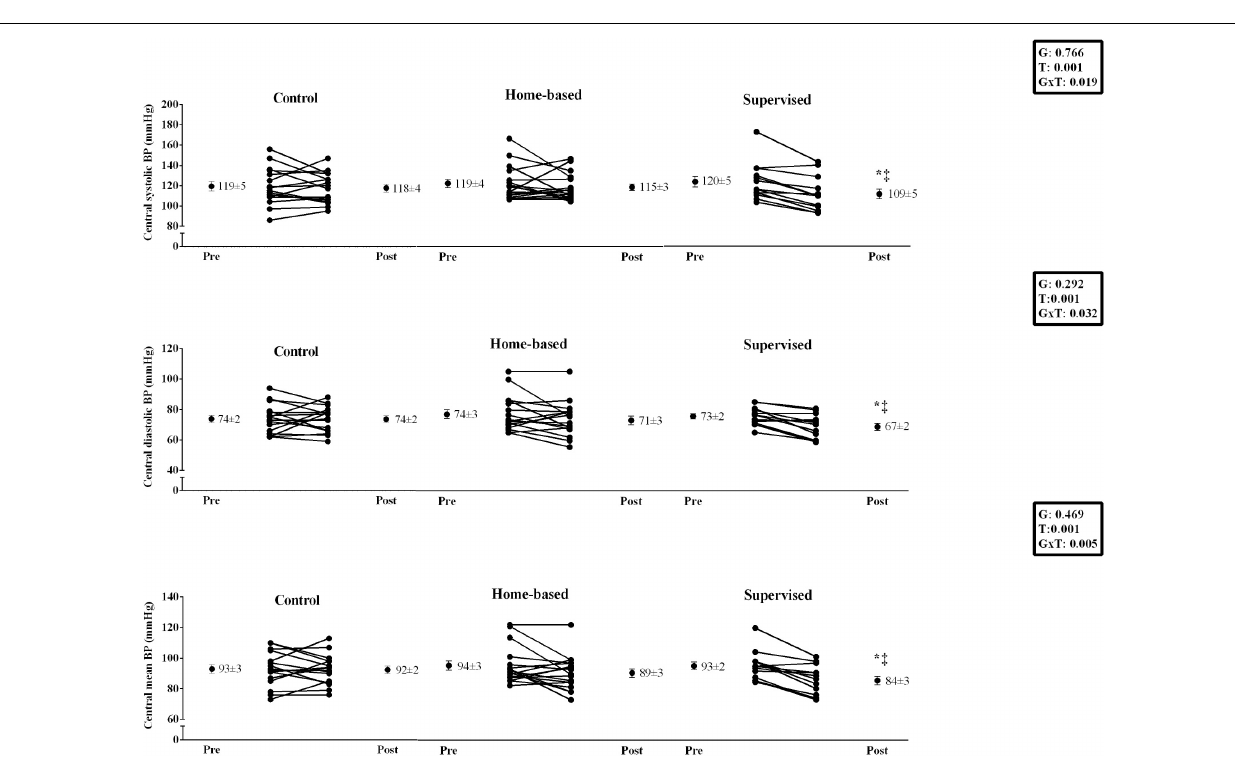
FIGURE 3 | Effects of home-based and supervised isometric handgrip training on central blood pressure. ∗ significant difference from Pre; ‡ significant difference from control